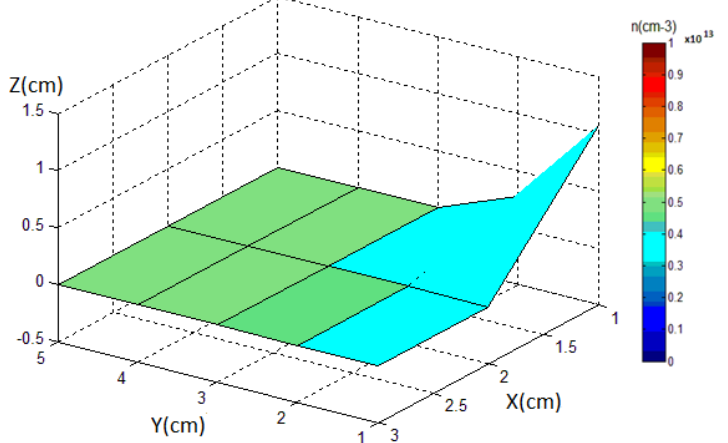
Figure 8: The spatial profile of electron number density of carbon laser induced plasma at